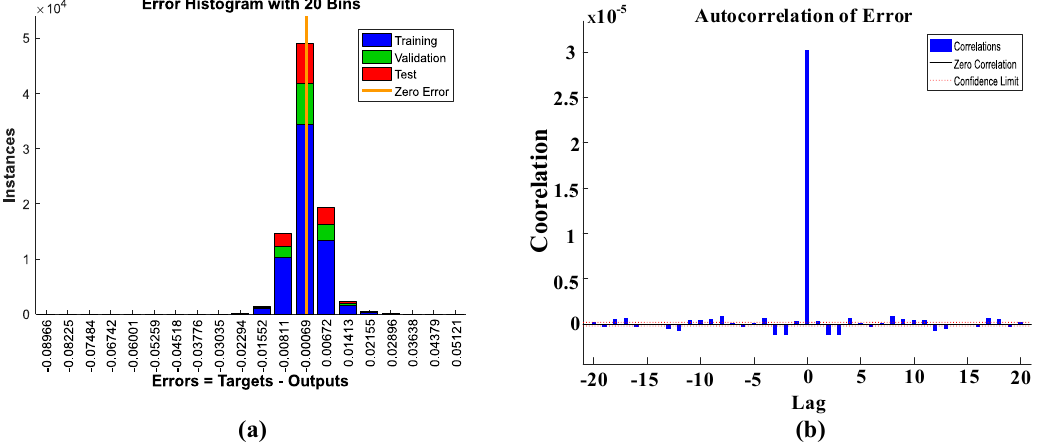
Figure 14. ( a ) Error histogram and ( b ) error auto correlation with lag inputs.